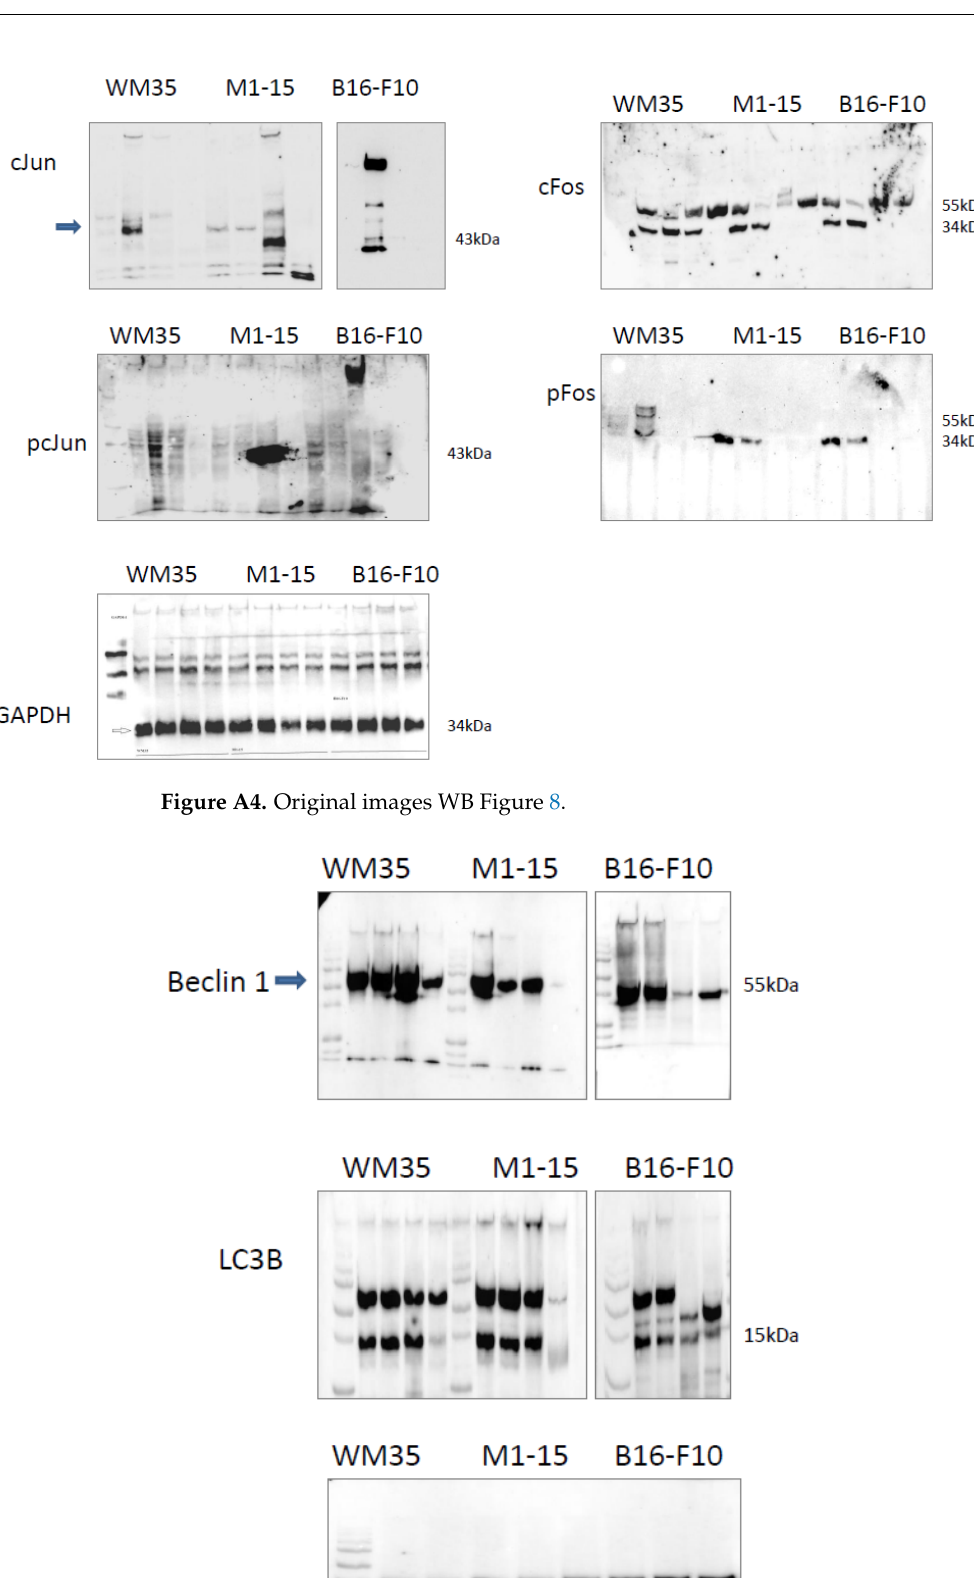
Figure A5. Original images WB Figure 9.